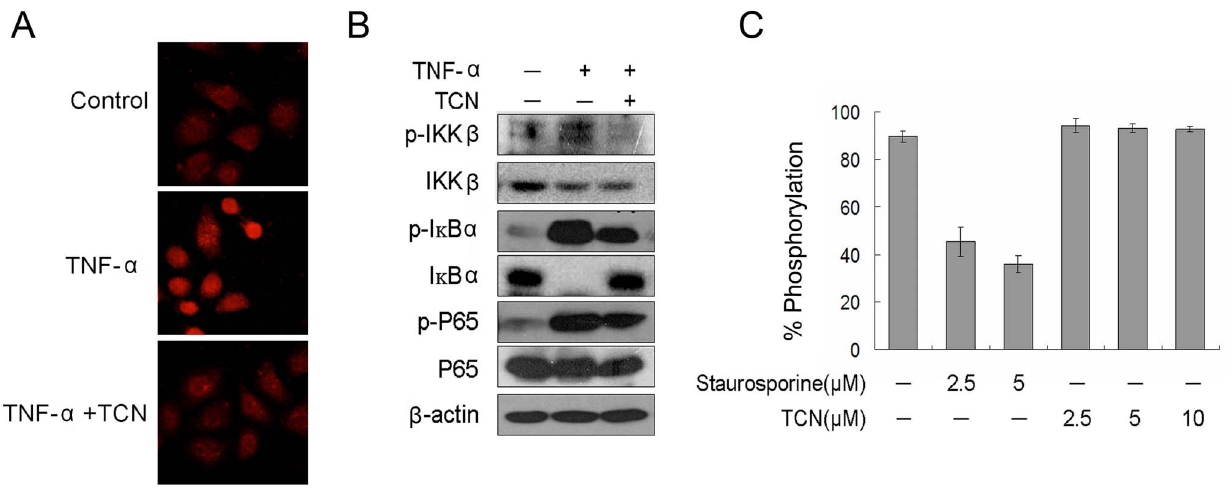
Figure 4. TCN inhibits the phosphorylation of IKK b . (A) IKK b phosphorylation was detected by phospho-IKK b antibody in HepG2 cells stimulated with 25 ng/mL TNF- a for 10 min. Cells were fixed, permeabilized, and examined by fluorescence microscope. (B) Western blot analysis showing the inhibition of IKK b phosphorylation in cells treated with 2.5 m M TCN. Cells were collected after stimulated with 25 ng/mL TNF- a for 10 min. (C) IKK b kinase activity was analyzed with recombinant IKK b using the Z’-LYTE TM kinase assay kit. Fluorescence was detected at 400 nm for the excitation wavelengths and 445 nm and 520 nm for the emission wavelengths. Experiments were done independently in triplicate and the results are reported as means and standard deviations. RNA Interference HepG2 cells were transiently transfected with a scrambled